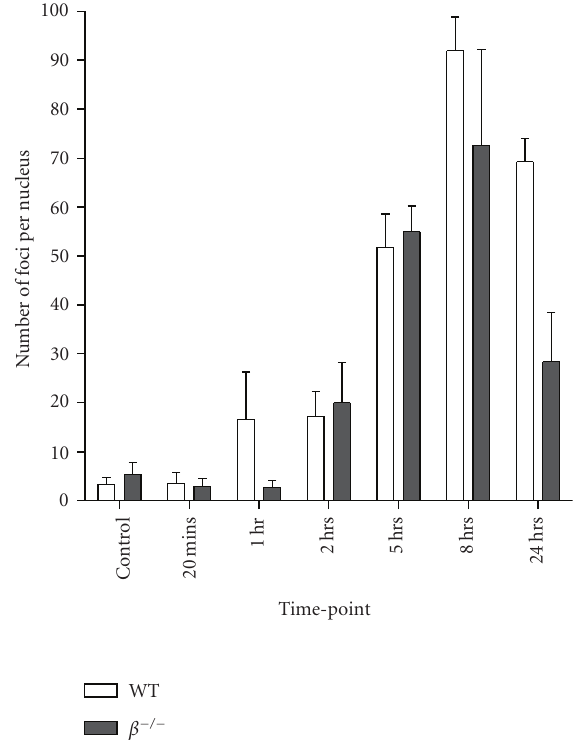
Figure 4: γ H2AX foci during continuous exposure to etoposide up to 24 hours. WT and TOP2 β − / − MEFs were exposed to 1 μ M etoposide and γ H2AX foci were counted at the indicated time points up to 24 hours. The data are derived from at least n = 3 independent experiments, each data point shows the mean ±